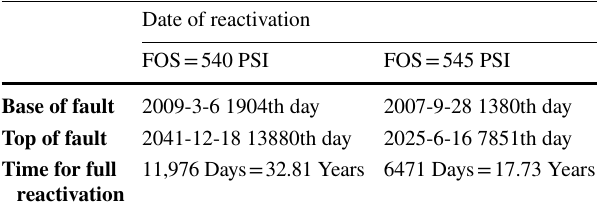
Fig. 16 Time taken for complete fracture propagation throughout the vertical thickness of the reservoir Table 8 Time taken for complete reactivation along the entire length of the